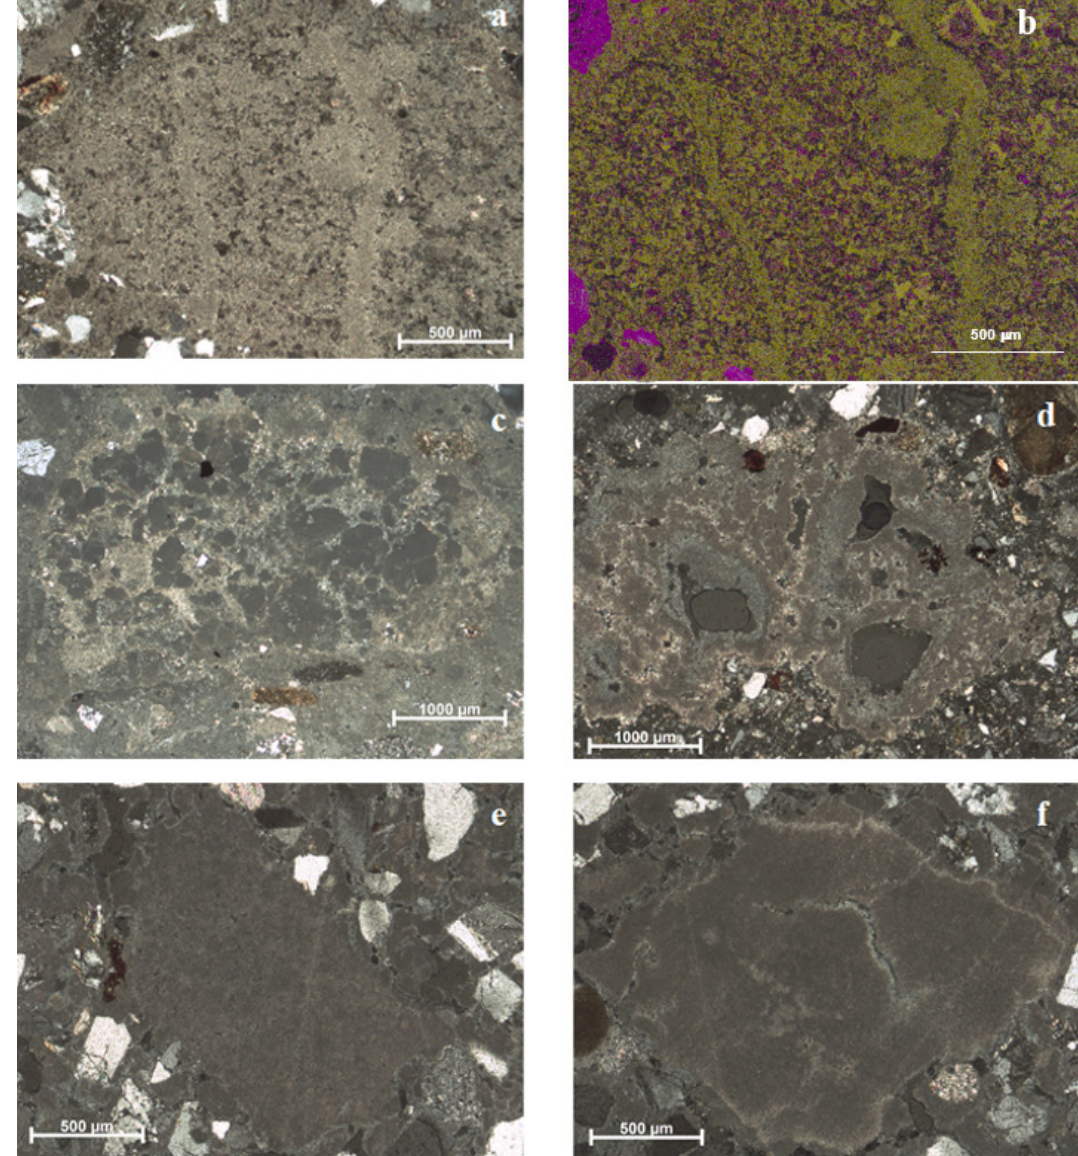
Figure 11. Microphotographs of different type of lumps: (Figure 11a,c,d,e,f, are under PLM, xpl) ( a ) under-burnt fragment of marly limestone (Pietra Alberese) from a mortar of a Florentine county house of (19th century); ( b ) SEM EDS layered map (Ca: yellow, Si: pink) of the same under-burnt fragment of Pietra Alberese; ( c ) under-burnt marble fragment in the bedding mortar of the Roman theatre of Luni (1st century AD); ( d ) under-burnt fragment of travertine from a bedding mortar of Ambulatio of Torraccia di Chiusi archaeological site (second half of 4th century AD); ( e ) unmixed binder in a mortar from San Francesco Church (Pisa) 13th–17th century; and ( f ) burnt limestone fragment hydrated and carbonated after setting from San Francesco Church (Pisa) 13th–17th cen- tury.